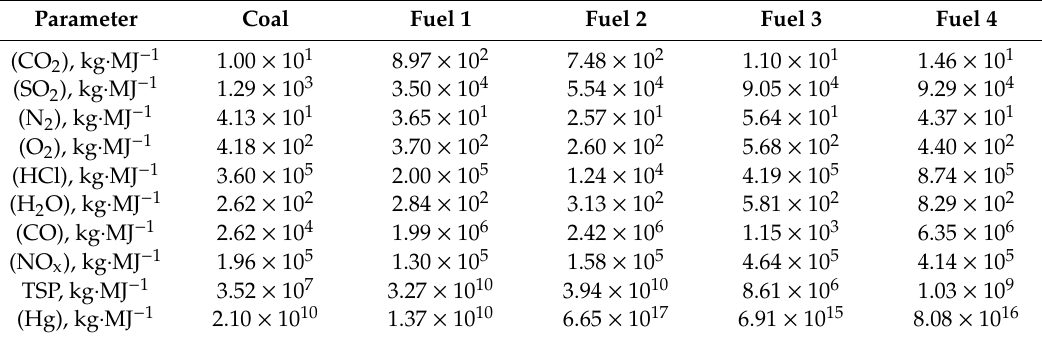
Table 5. The value of exhaust emissions for 1 MJ of energy obtained.